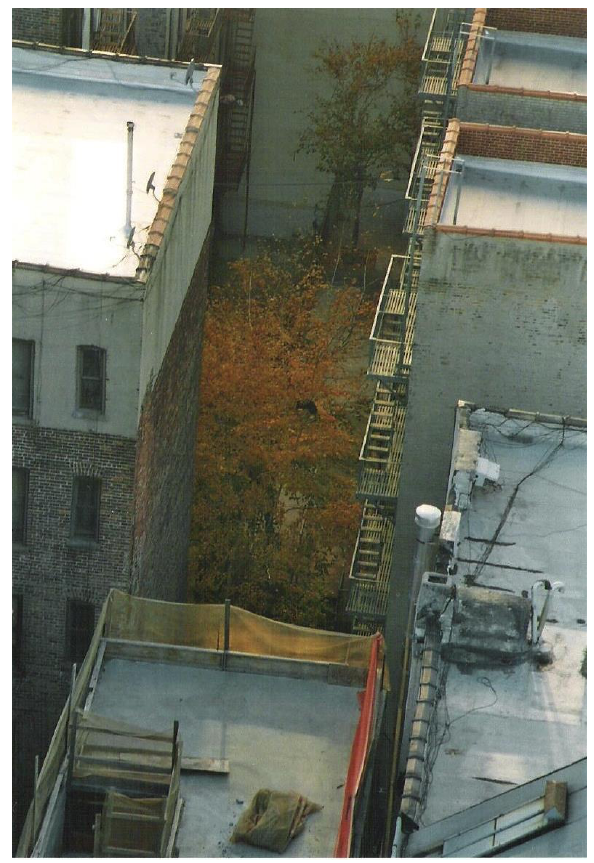
Figure 2. The tree.